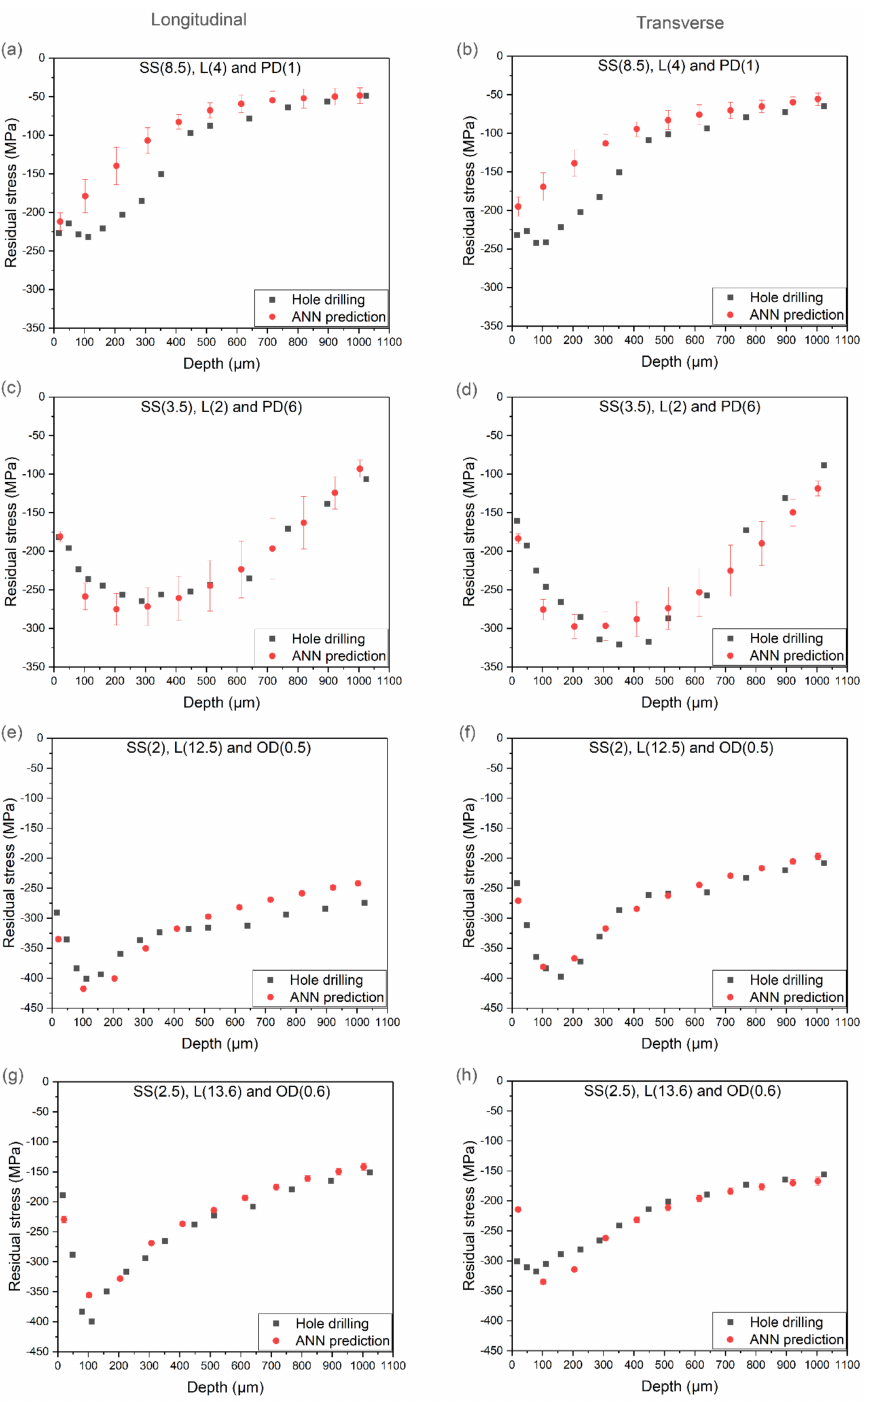
Figure 11. Case studies showing the predicted residual stresses as a function of depth using the ANN model. Uncertainty bounds calculated using mean ± standard deviation from the output distribution of six committee networks. Predictive results using dataset 1 shown in ( a – d ) and dataset 2 in ( e – h ), respectively. Acronyms stands for spot size (SS), layers (L), power density (PD) and offset distance